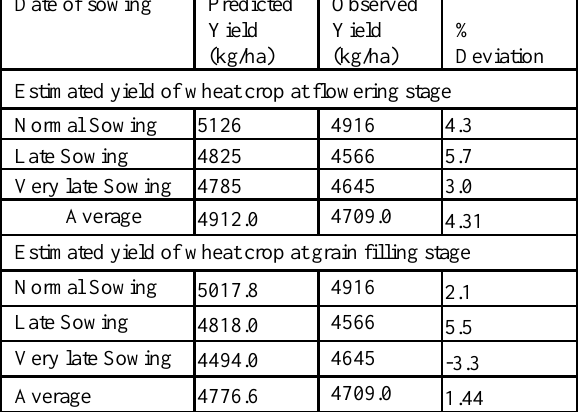
Table 2: Percentage deviation of observed yield from estimated yield of wheat crop by InfoCrop model ( Rabi 2016-17)